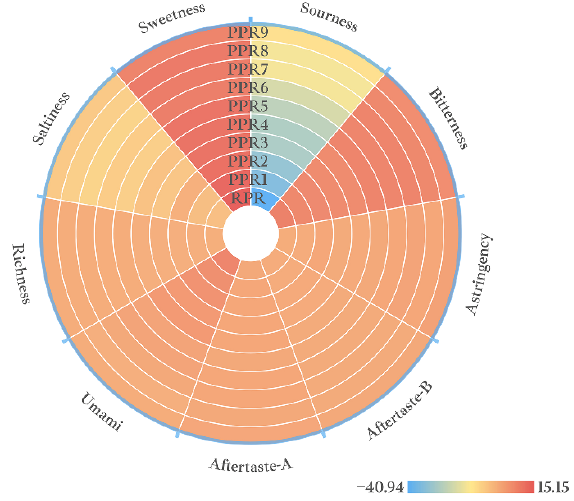
Figure 4. Taste characteristics of PR samples with different processing levels.